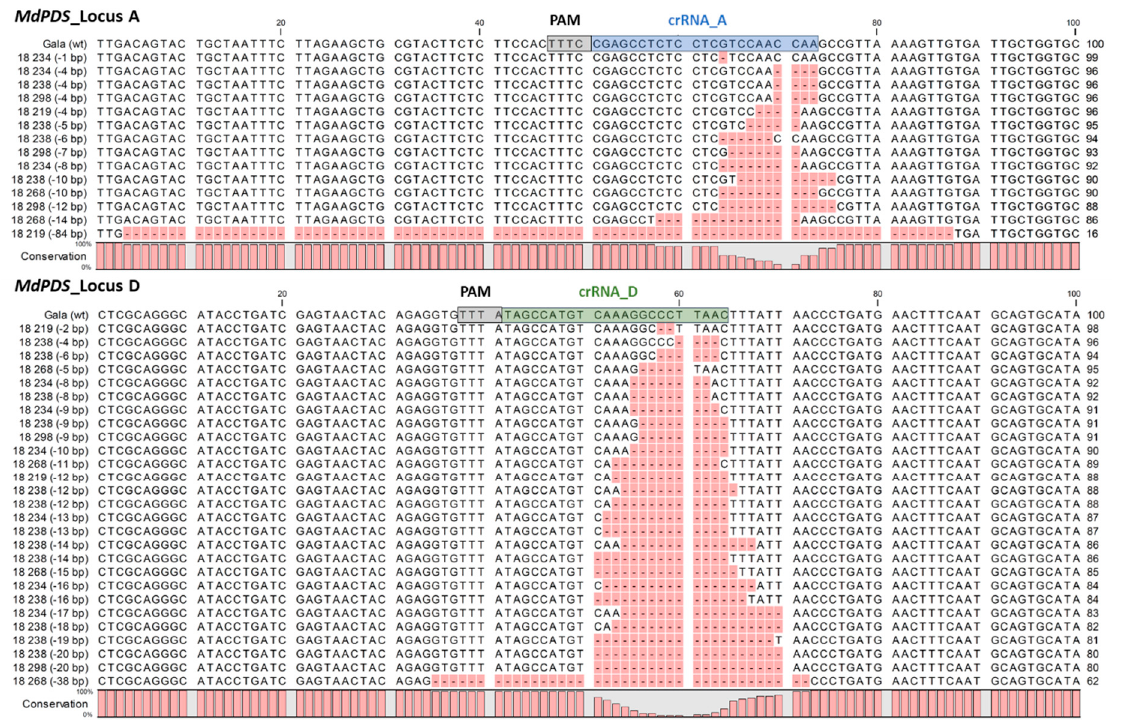
Figure 4. GE events in the apple MdPDS gene introduced by Lb Cas12a. The genomic loci ( MdPDS _locus A and D) of different apple regenerates transformed with the CRISPR/ Lb Cas12a construct were sequenced by amplicon deep sequencing. All resulting unique sequences containing GE events were aligned to the reference sequence from wt ‘Gala’ and sorted by deletion length in ascending order. The protospacer adjacent motif (PAM) and the target sites of the crRNAs A (blue) and B (green) are indicated in the wt sequence.